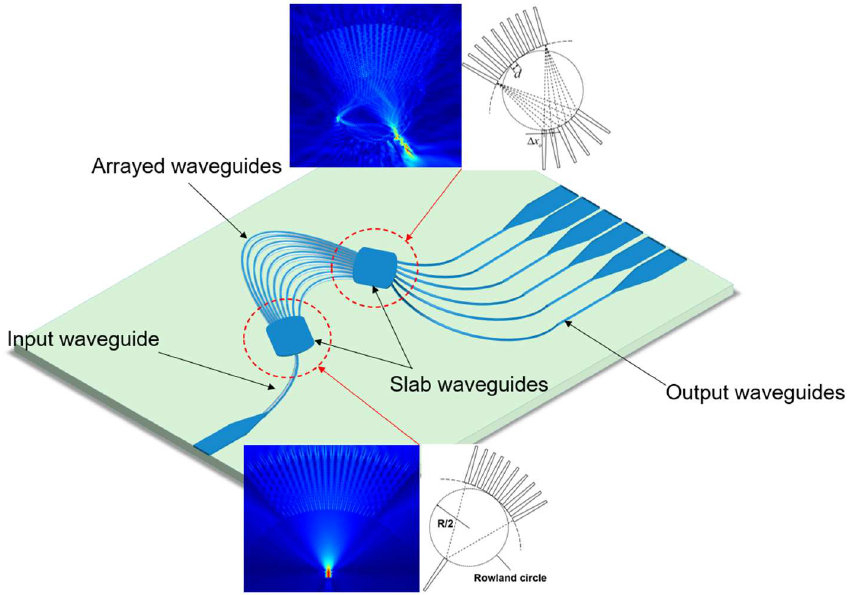
Figure 2. Structural diagram of AWG.